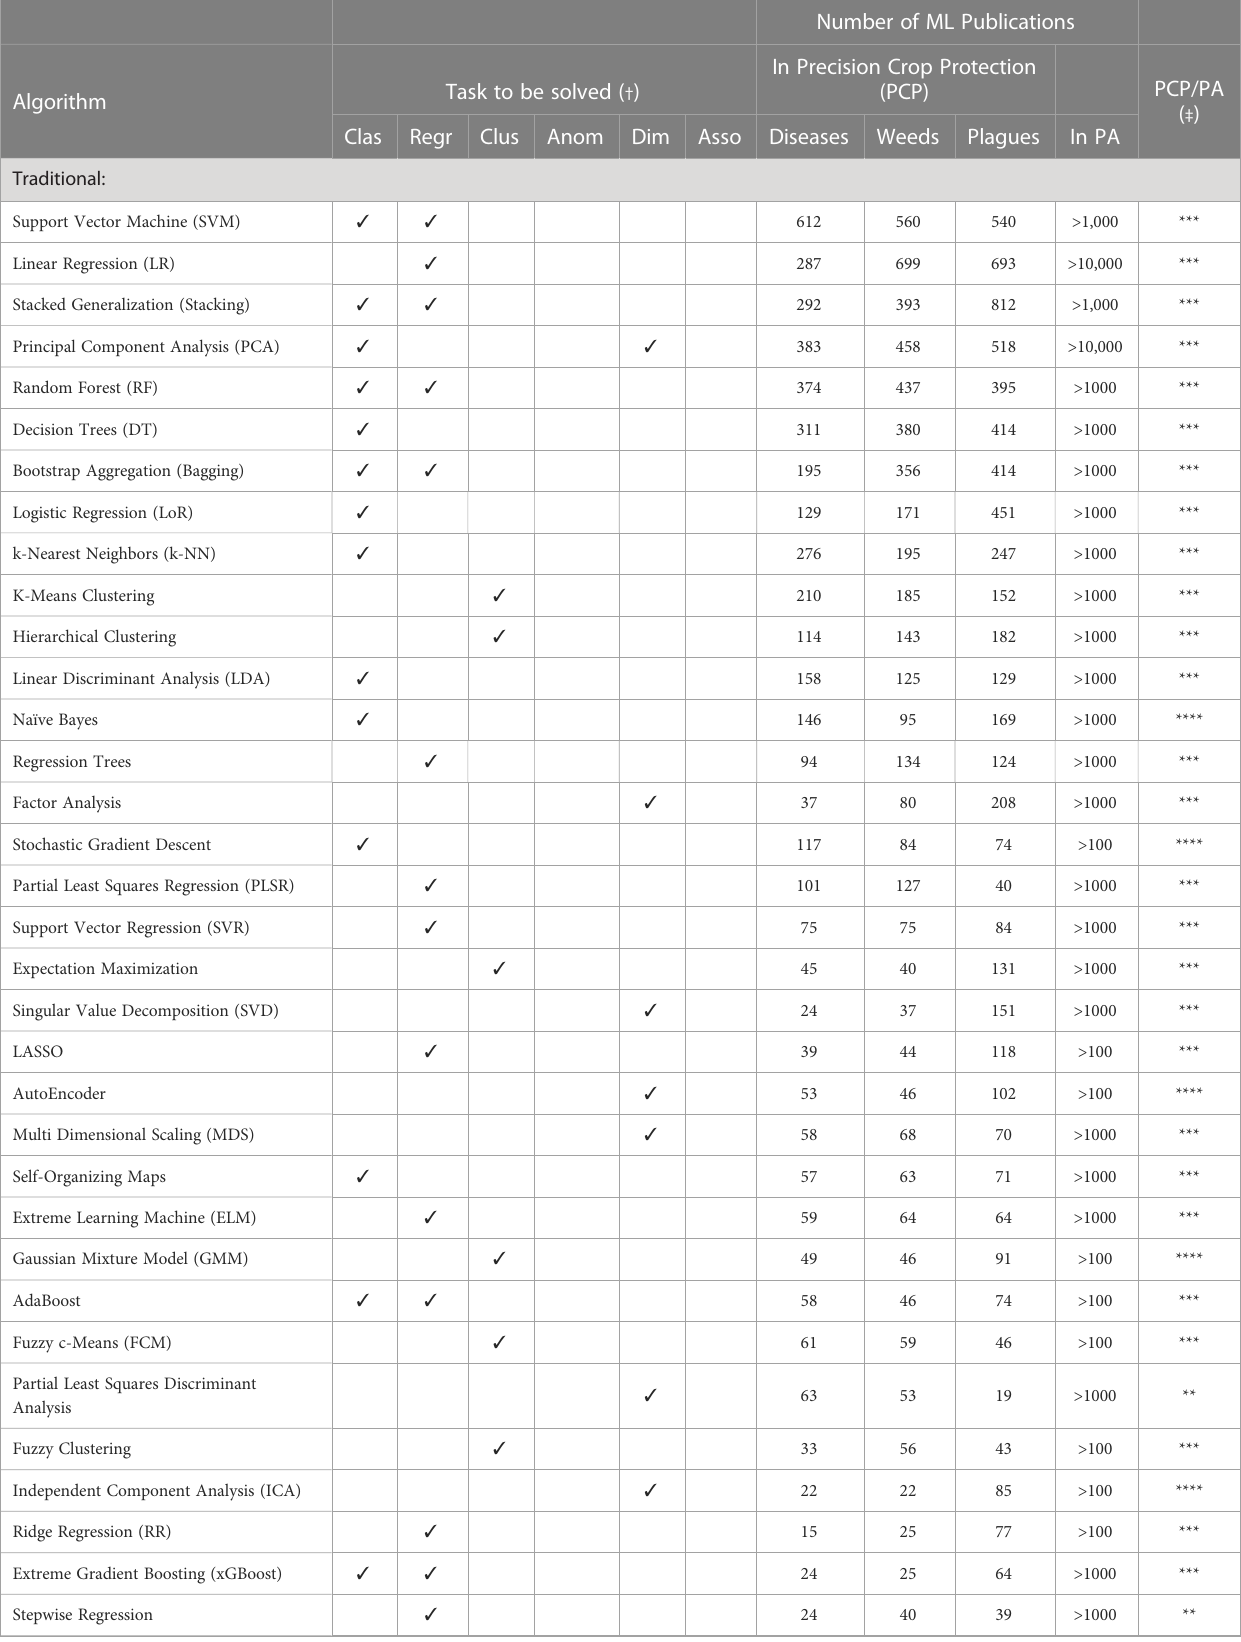
TABLE 2 Numbers publications of machine learning algorithms according to the proposal taxonomy (source